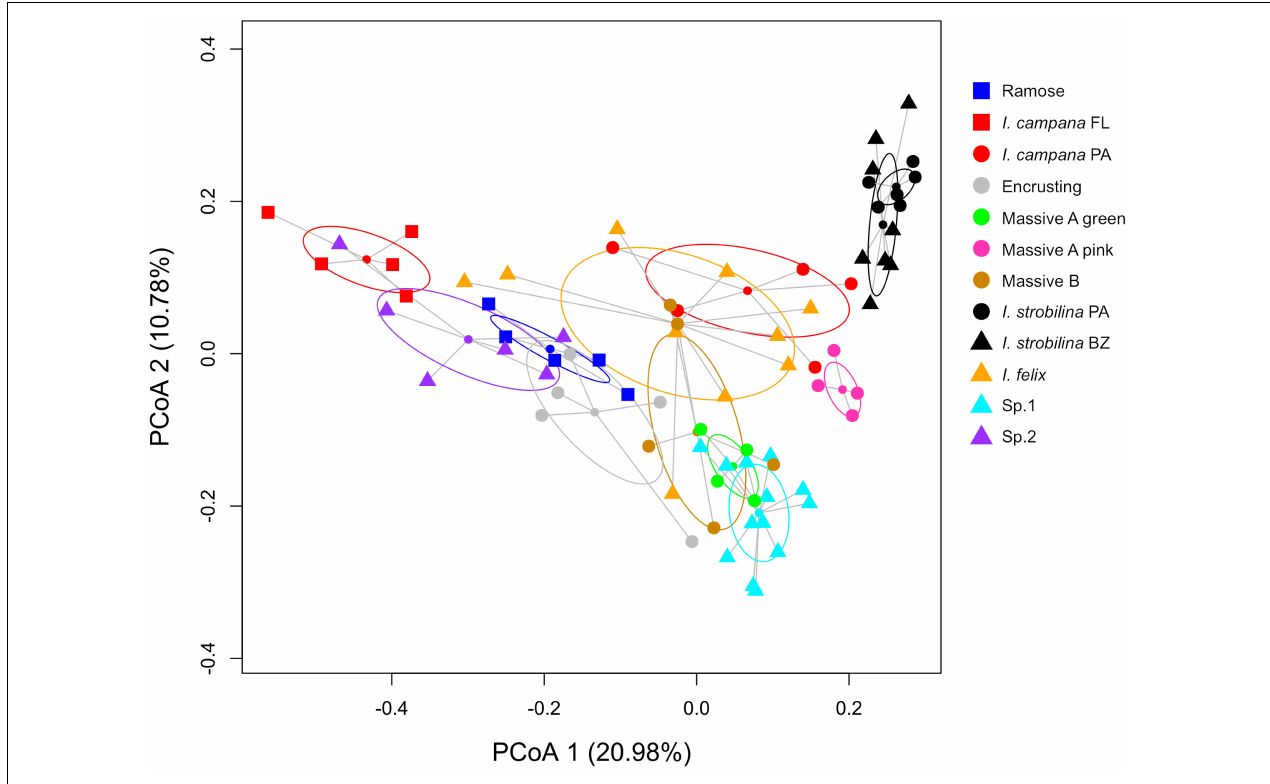
FIGURE 3 | PCoA of microbiome compositions, normalized by relative abundance, for each host lineage. Ellipses are standard ellipse area (SEA). Squares are Floridian specimens (FL), circles are Panamanian specimens (PA), and triangles are Belizean specimens (BZ).